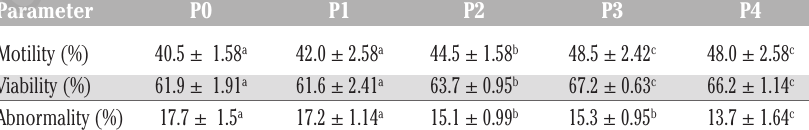
Table 2. Sperm motility, viability, and abnormality at suplementation of various dosage